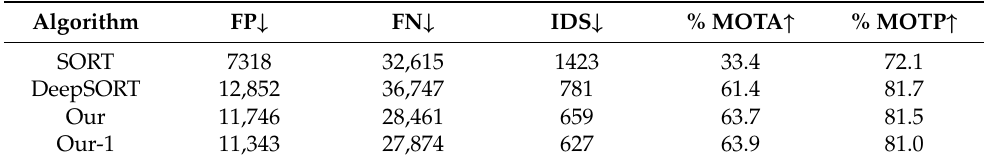
Table 1. Algorithmic performance